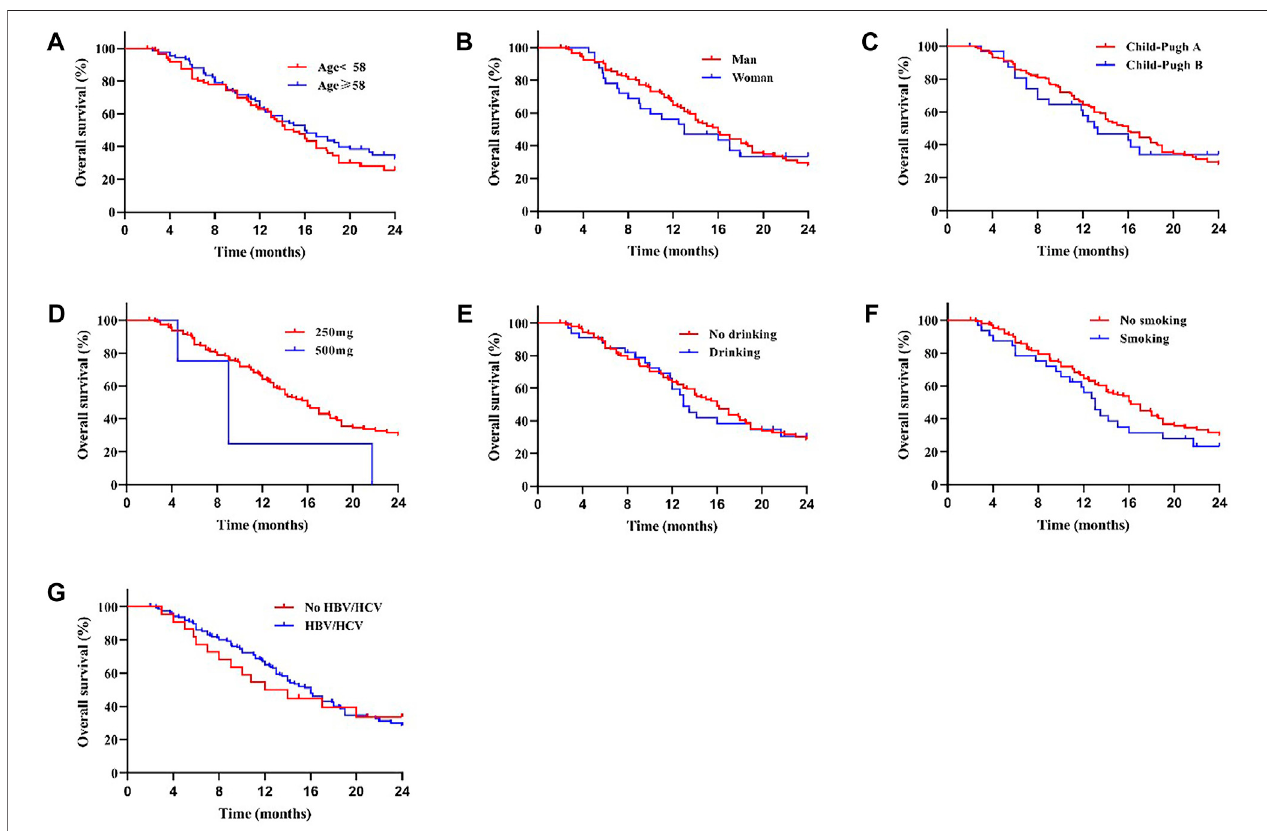
FIGURE5| Therewasnosigni fi cantdifferenceinmOSbetweenpatients withdifferentage (A) ,sex (B) ,Child-Pugh class (C) ,drug dose (D) ,whether withdrinking (E) or smoking (F) history, and whether with HBV/HCV (G) (All p > 0.05).